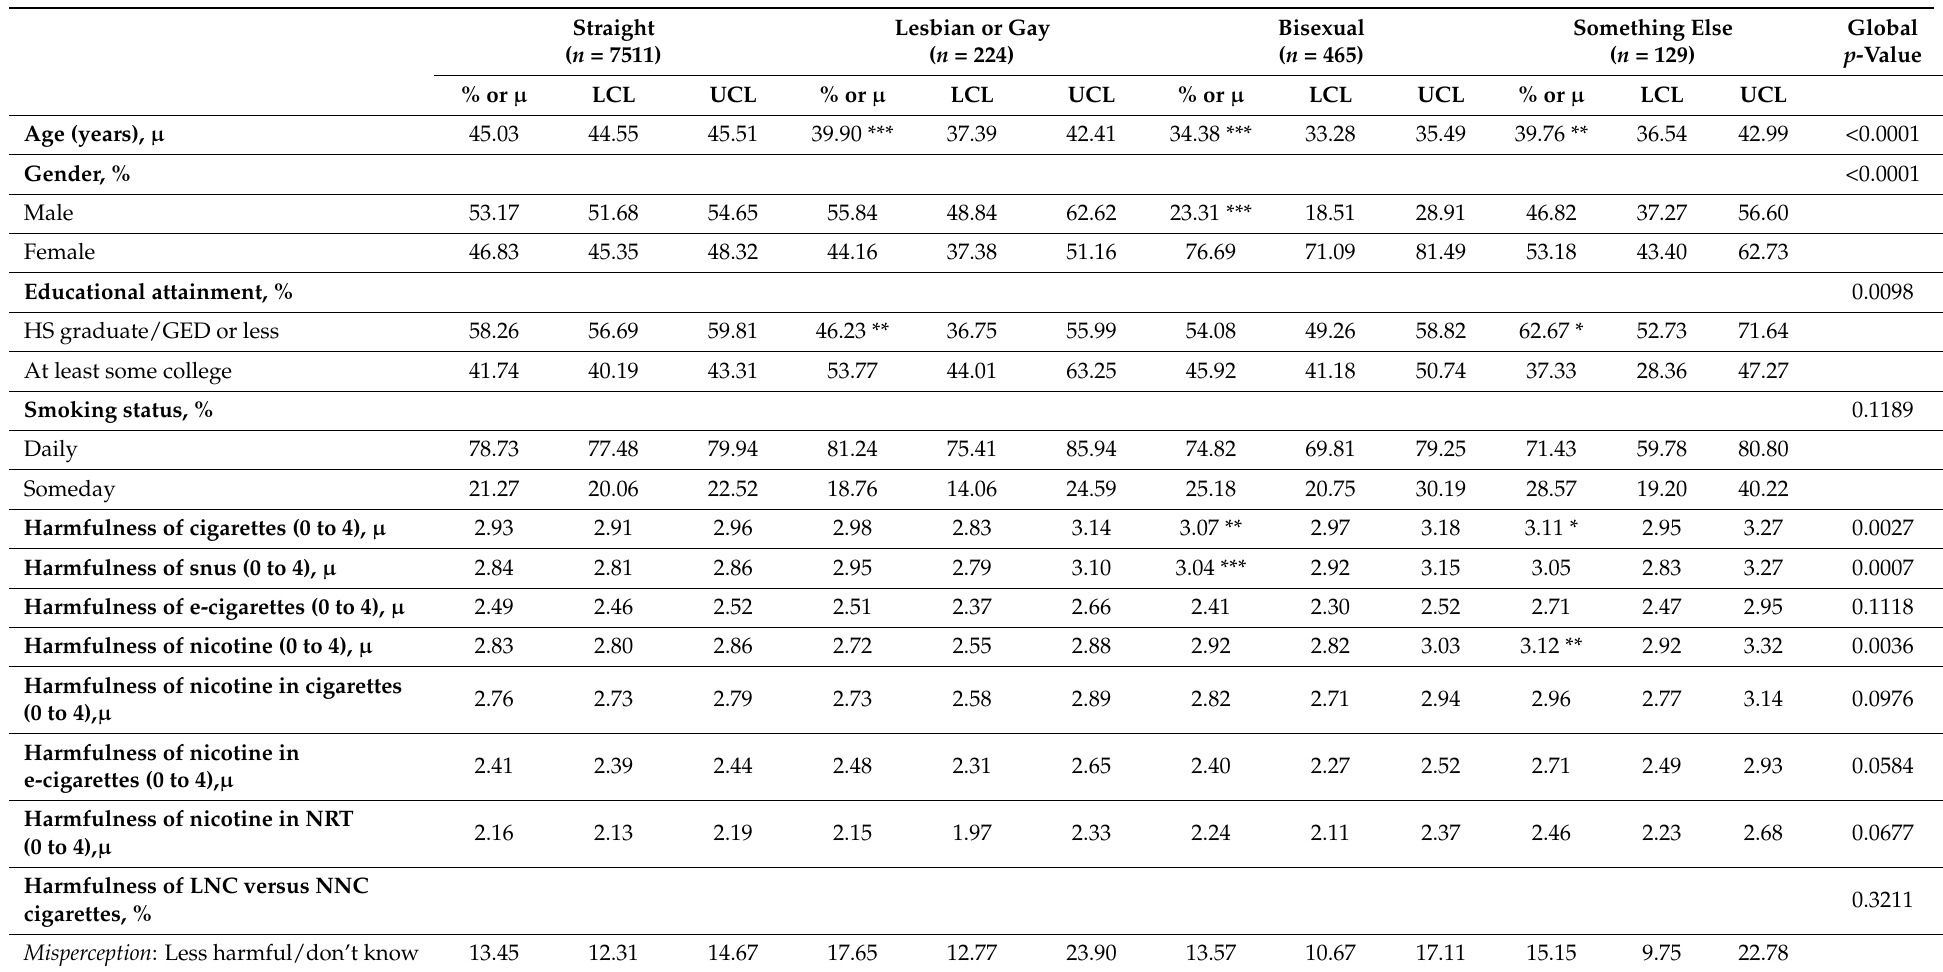
Table 2. Weighted mean values or weighted proportions and corresponding 95% confidence intervals; PATH Wave 4 adults; Current established daily or someday smokers who are not established users of non-combustible products by sexual